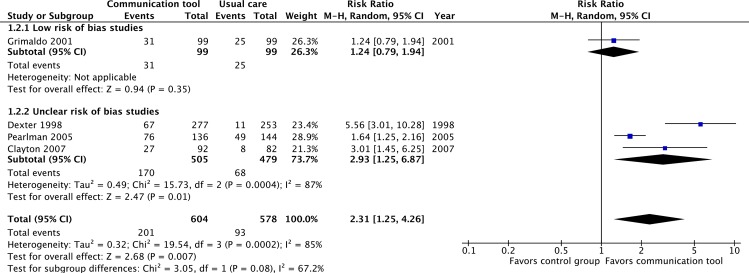
Proportion of patients with documented advance care planning discussions.